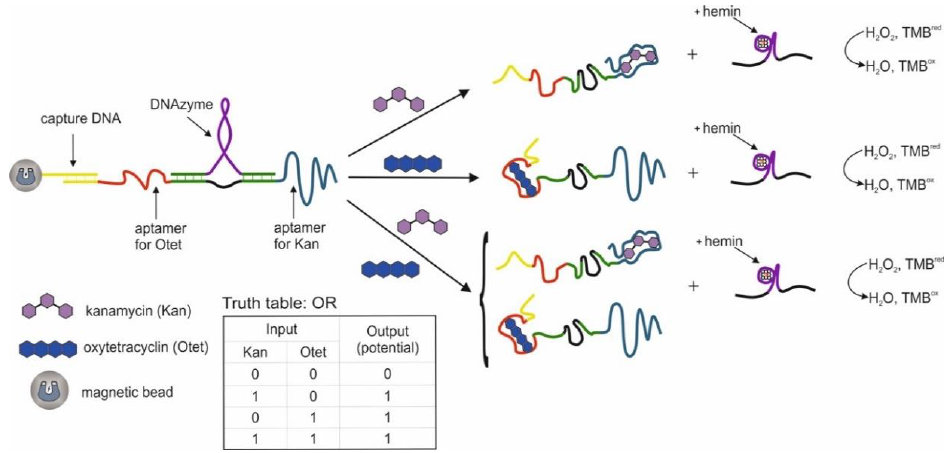
Figure 13. The OR logic gate. TMB = 3,3′,5,5′-tetramethylbenzidine hydrochloride. Adapted from